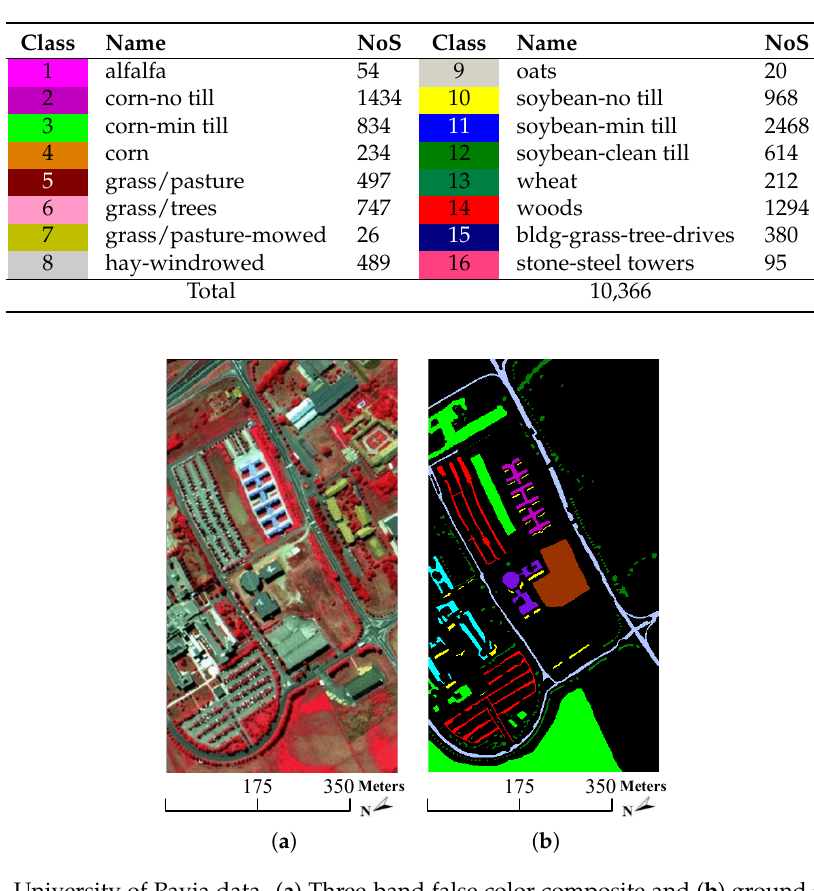
Figure 7. University of Pavia data. ( a ) Three-band false color composite and ( b ) ground truth data with 9